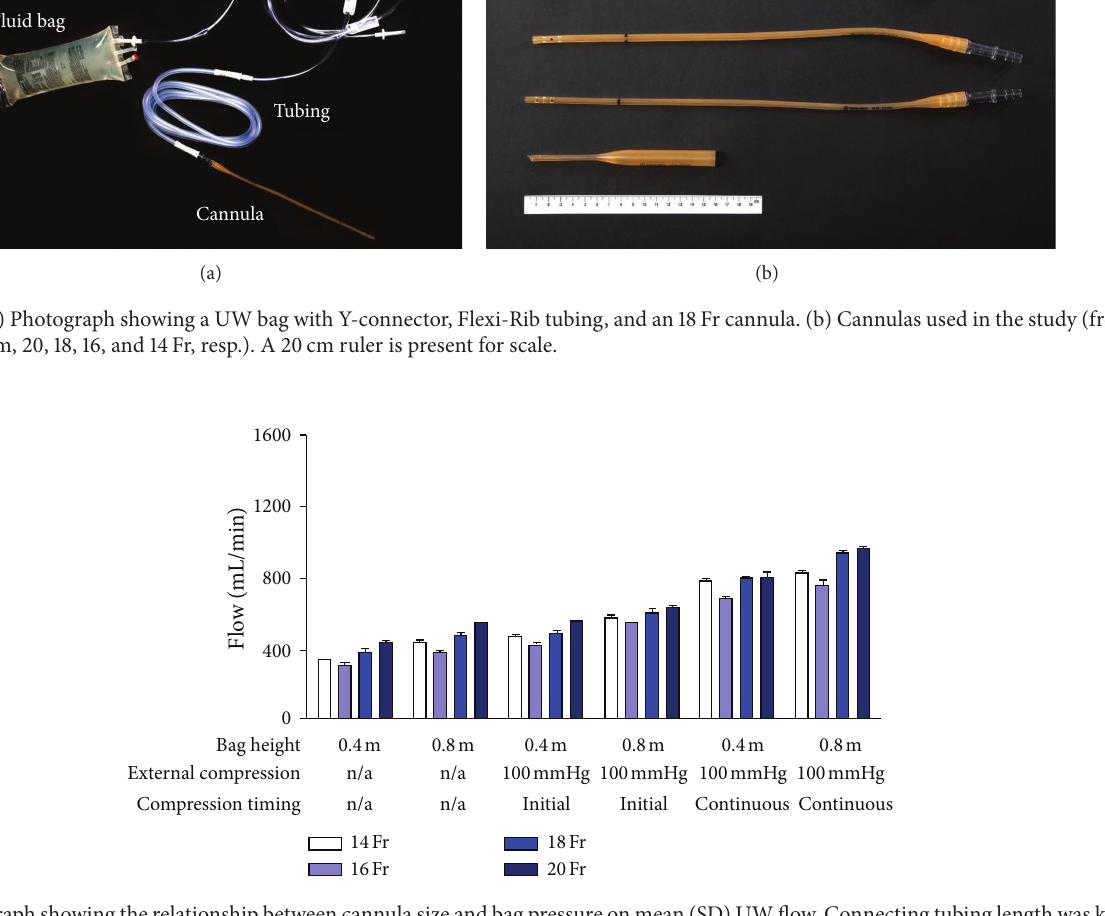
Figure 3: Graph showing the relationship between cannula size and bag pressure on mean (SD) UW flow. Connecting tubing length was kept constant at 3m.